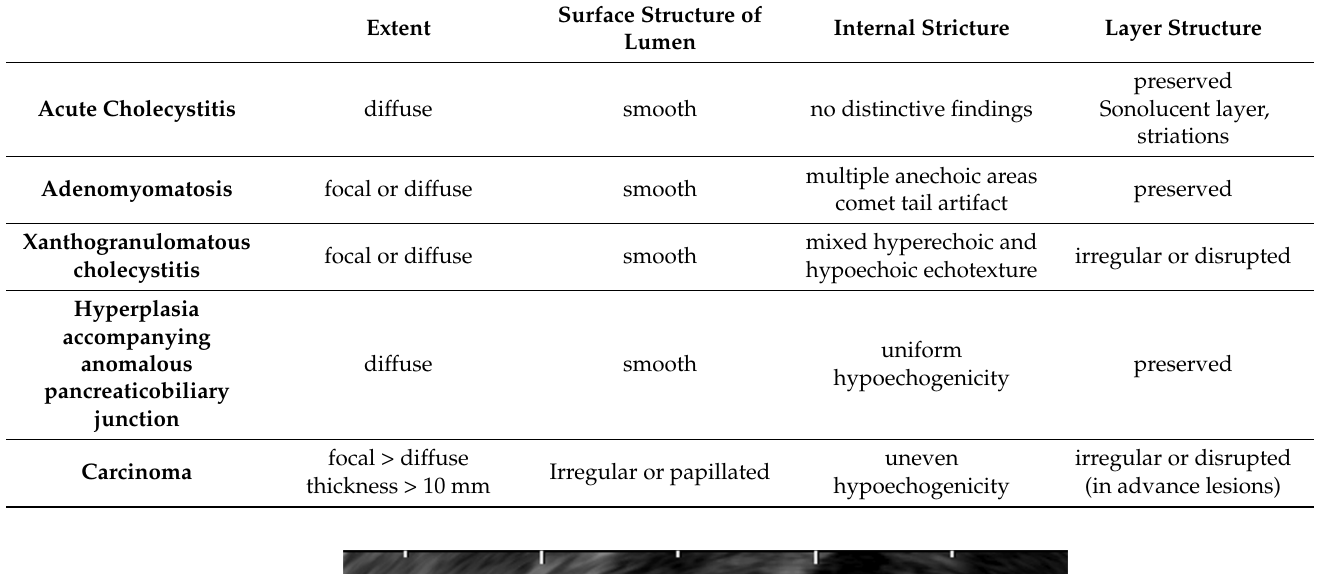
Table 4. EUS features of major GB wall-thickening lesions.